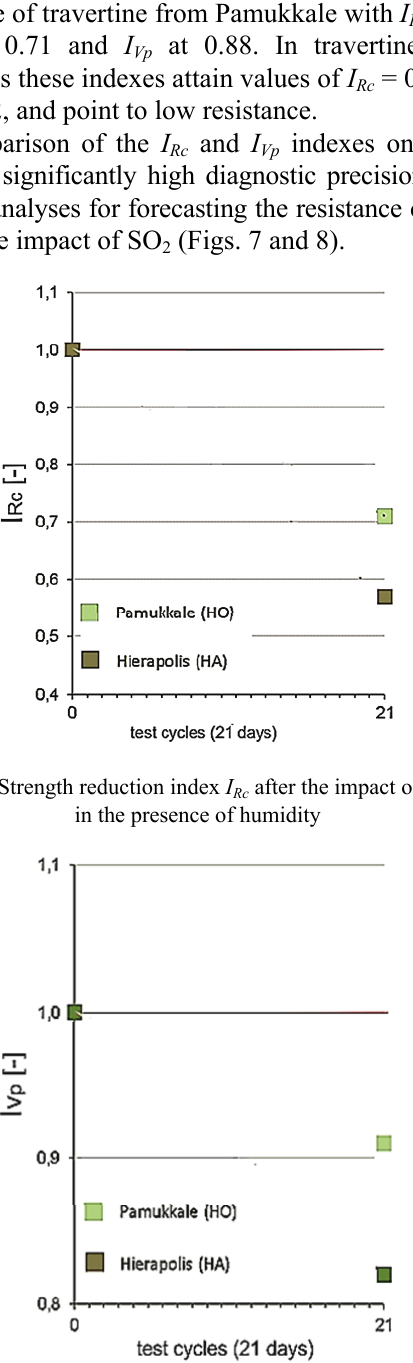
Fig. 8. Ultrasonic waves index I Vp after the impact of SO 2 in the presence of humidity